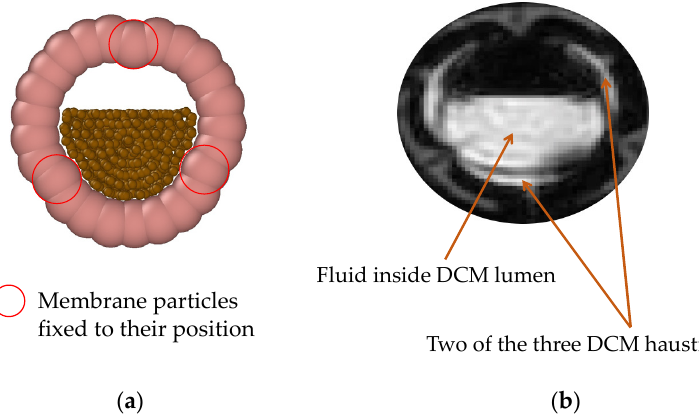
Figure 5. Shape of the segment during relaxing, where ( a ) is the computational model and ( b ) is a segment of the DCM.